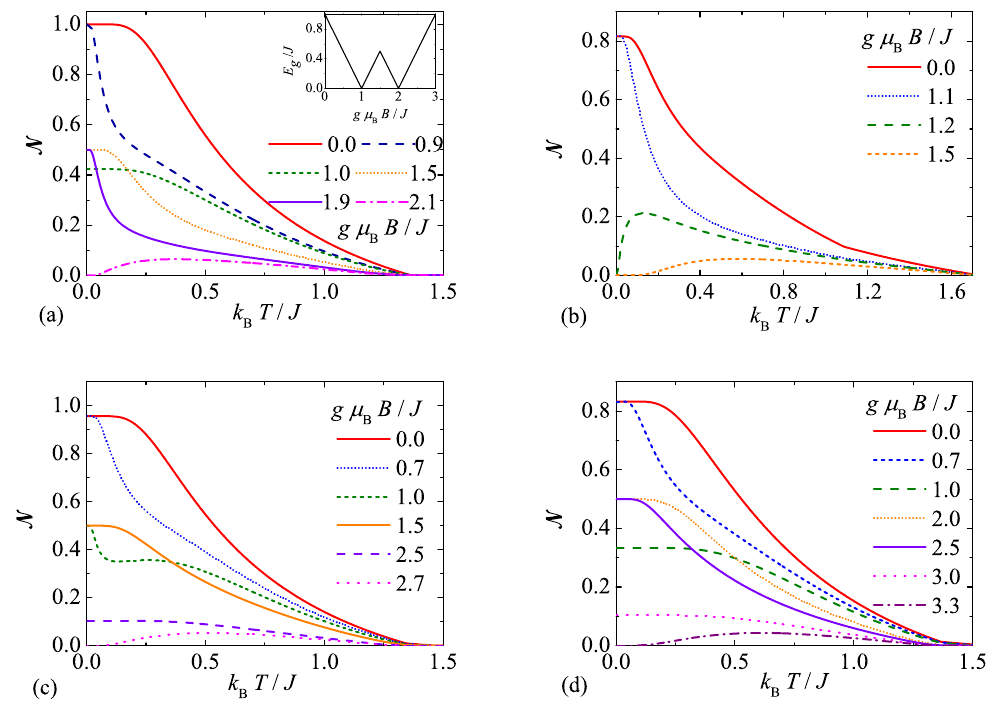
Figure 3. Temperature variations of the negativity of the spin-1 Heisenberg dimer for the particular case with the isotropic exchange coupling ∆ = 1, a few selected values of the magnetic field (see legend) and four different values of the uniaxial single-ion anisotropy: ( a ) D / J = 0.0; ( b ) D / J = − 2.0; ( c ) D / J = 0.5; ( d ) D / J =